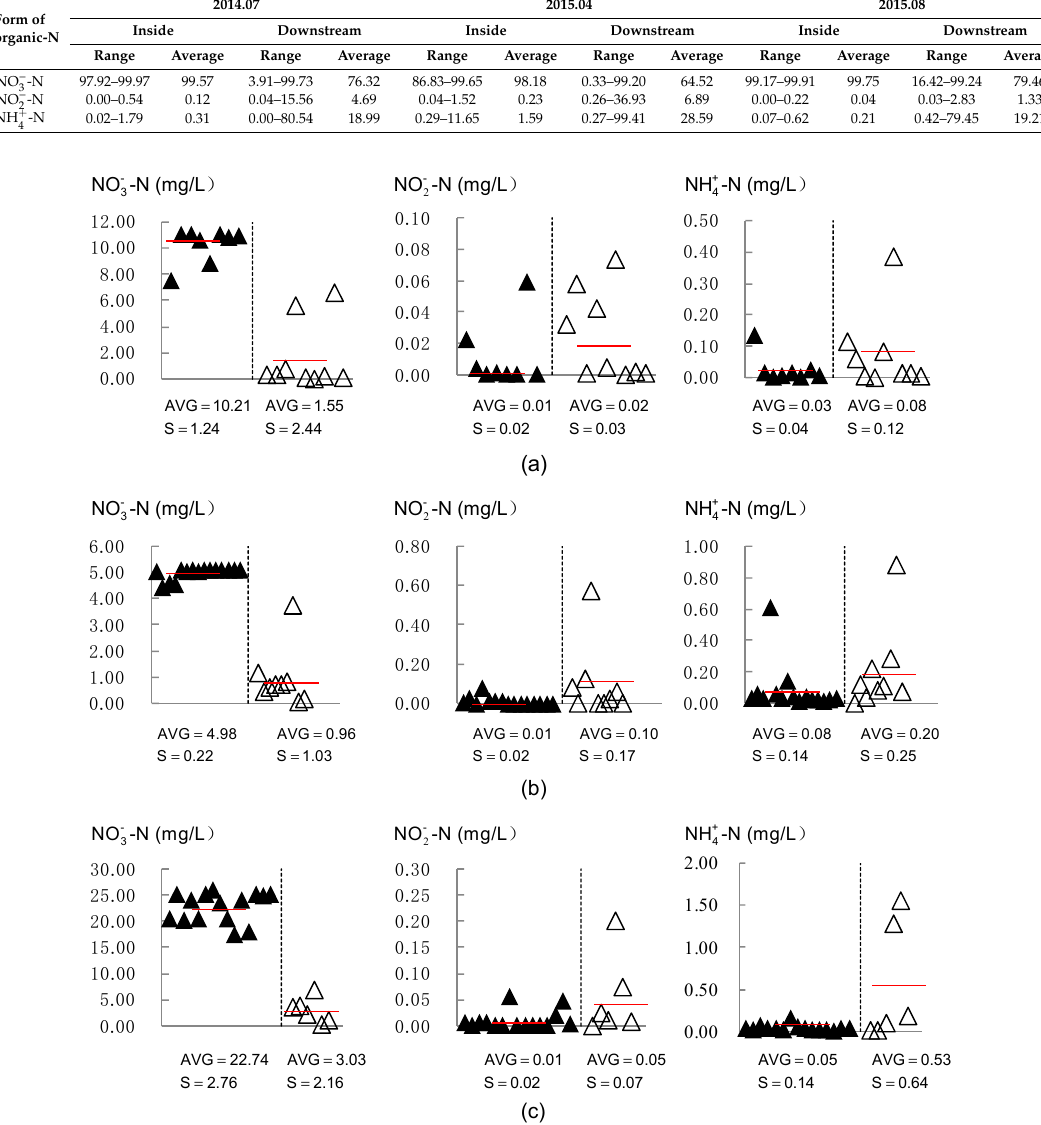
Figure 12. Groundwater NO − the downstream area in ( a ) July, 2014, ( b ) April, 2015, and ( c ) August, 2015 ( ▲ reservoir sampling site; △ downstream sampling site).